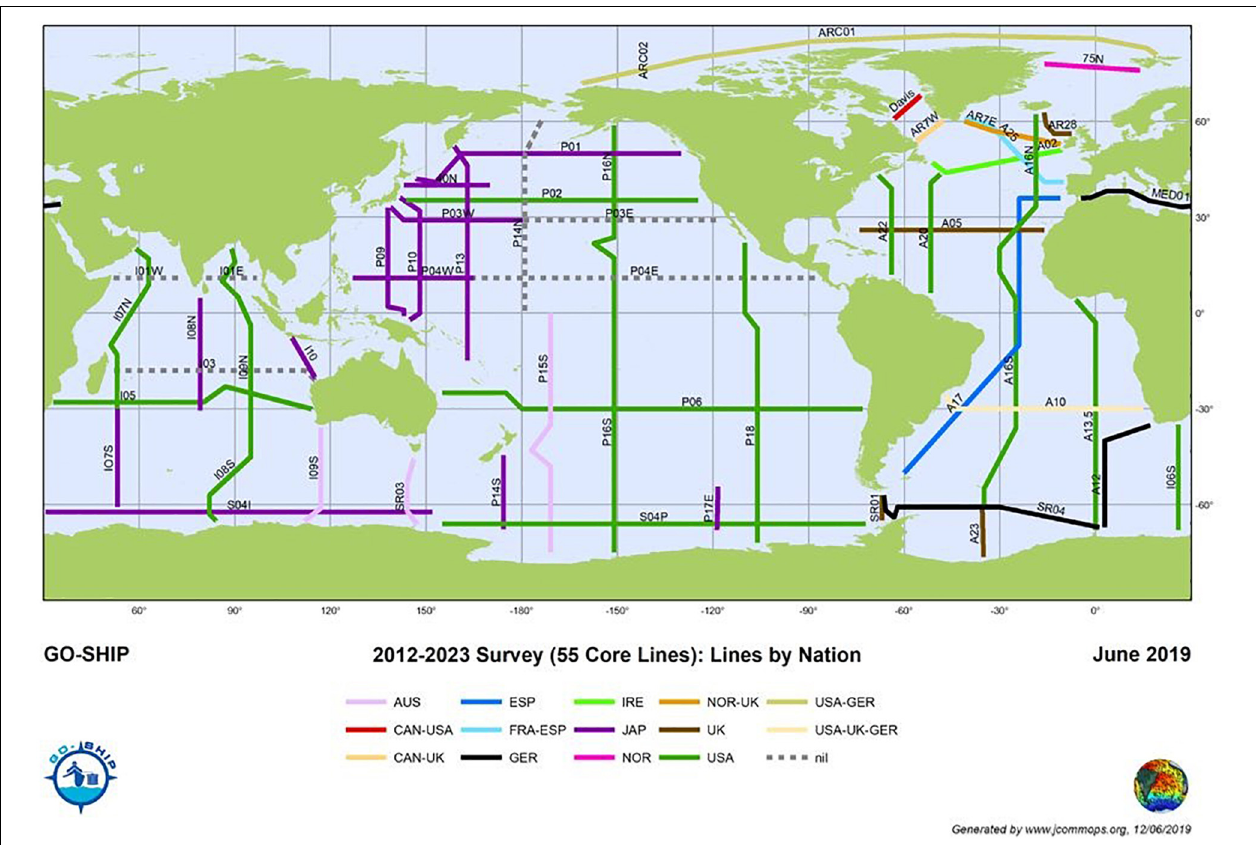
FIGURE 1 | Global Ocean Ship-Based Hydrographic Investigations Program (GO-SHIP) reference lines according the nations leading the effort (color coded).